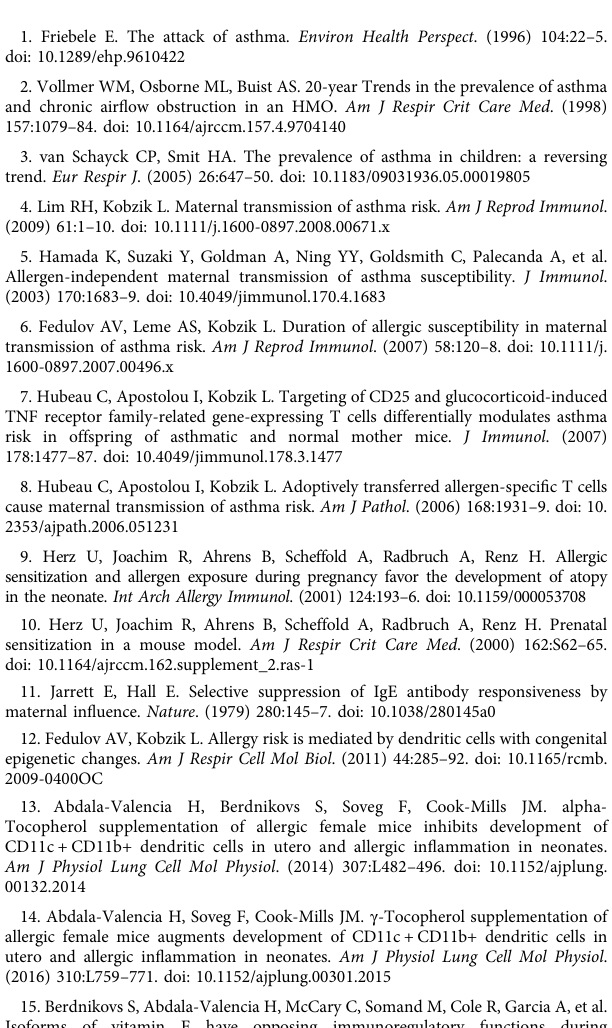
SUPPLEMENT FIGURE 1 Alpha-diversity of donor pup BALmicrobiota and allergen-challenged recipient pup microbiota. Data are from experiments in Figures 2, 3 and 4. Shannon Index for alpha-diversity which incorporates the total number of bacterial species and relative differences in the abundance of taxa in the community. ( A ) PND4 donor BAL microbiota communities. ( B ) PND16 BAL microbiota communities of allergen-challenged pups. Sal/B, saline-treated mother with basal diet. Sal/ α T, saline-treated mother with α T-supplemented diet. OVA/B, OVA allergen- treated mother with a basal diet. OVA/ α T, OVA allergen-treated mother with α T- supplemented diet. *. p < 0.045 for decrease as compared to no donor → Sal/B group. **. p < 0.035 for decrease as compared to Sal/B → Sal/B group. + . p < 0.04 for decrease as compared to no donor → Sal/ α T group. ++ . p < 0.045 for decrease as compared to OVA/ α T → OVA/ α T group. SUPPLEMENT FIGURE 2 Beta-diversity of donor pup BAL microbiota and allergen-challenged recipient pup microbiota. Data are from experiments in Figures 2, 3 and 4.